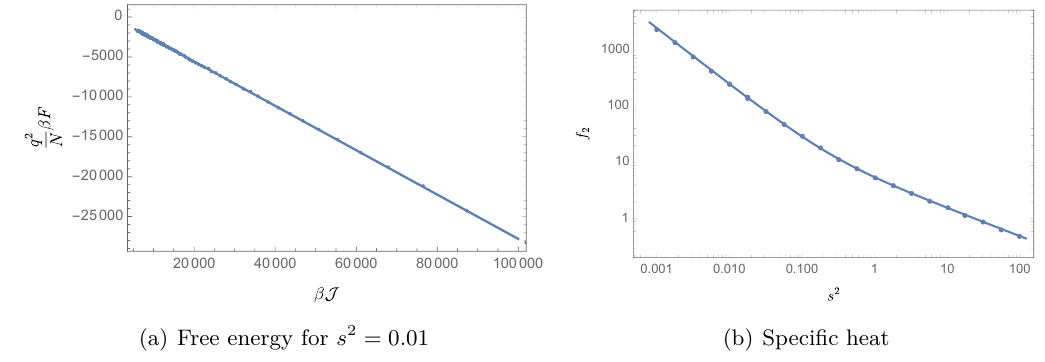
Figure 5 . (a) The free energy as a function of the inverse temperature for s 2 = 0 . 01 . The dots correspond to numerically integrating (D.6) for different temperatures, while the solid line corresponds to the analytic result at this value of the coupling. (b) The coefficient f of s 2 in a logarithmic scale. The dots correspond to numerically integrating the free energy at each s 2 and fitting by a function of the form of (D.8). The solid line is the analytic result f √ 4 s 2 + 1 / 4 s 2 π 2